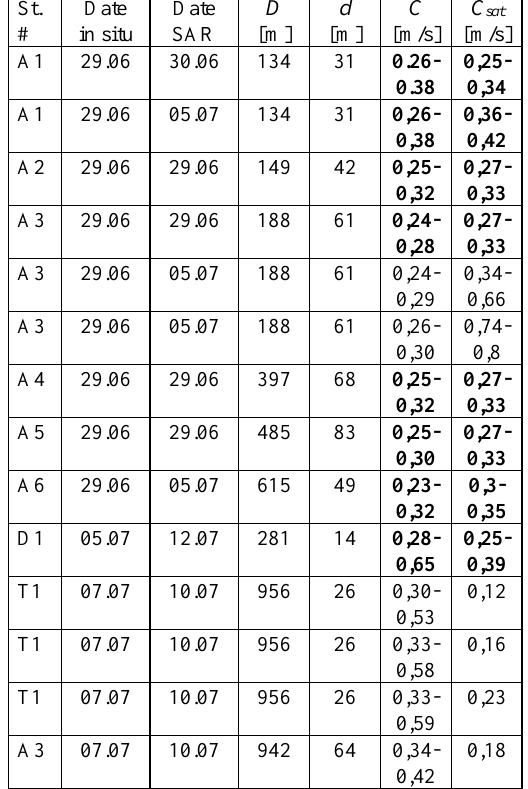
Table 1 . Comparison of SIW phase speed values obtained